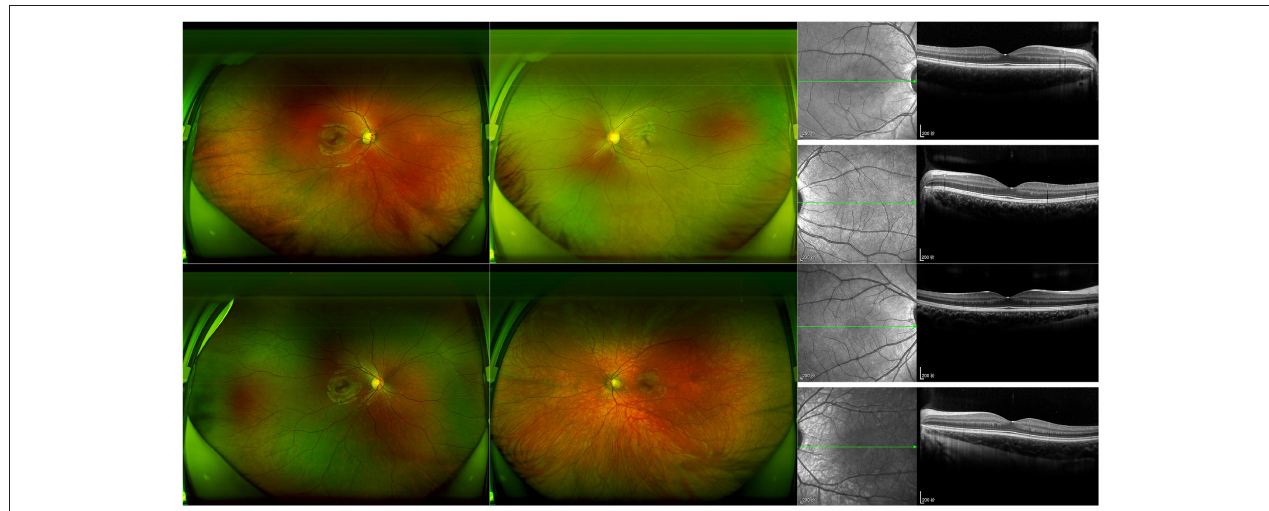
TABLE 1 | Summary of the six candidate variants of five genes in the Waardenburg Syndrome Type 1 pedigree. Gene PAX3 (NM_181457.4) Genomic